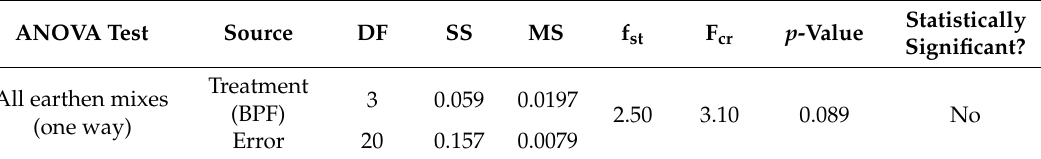
Figure 13. Flexural strength results for each earthen mix. Table 7. 5% significance level ANOVA tests for the flexural strength of earthen